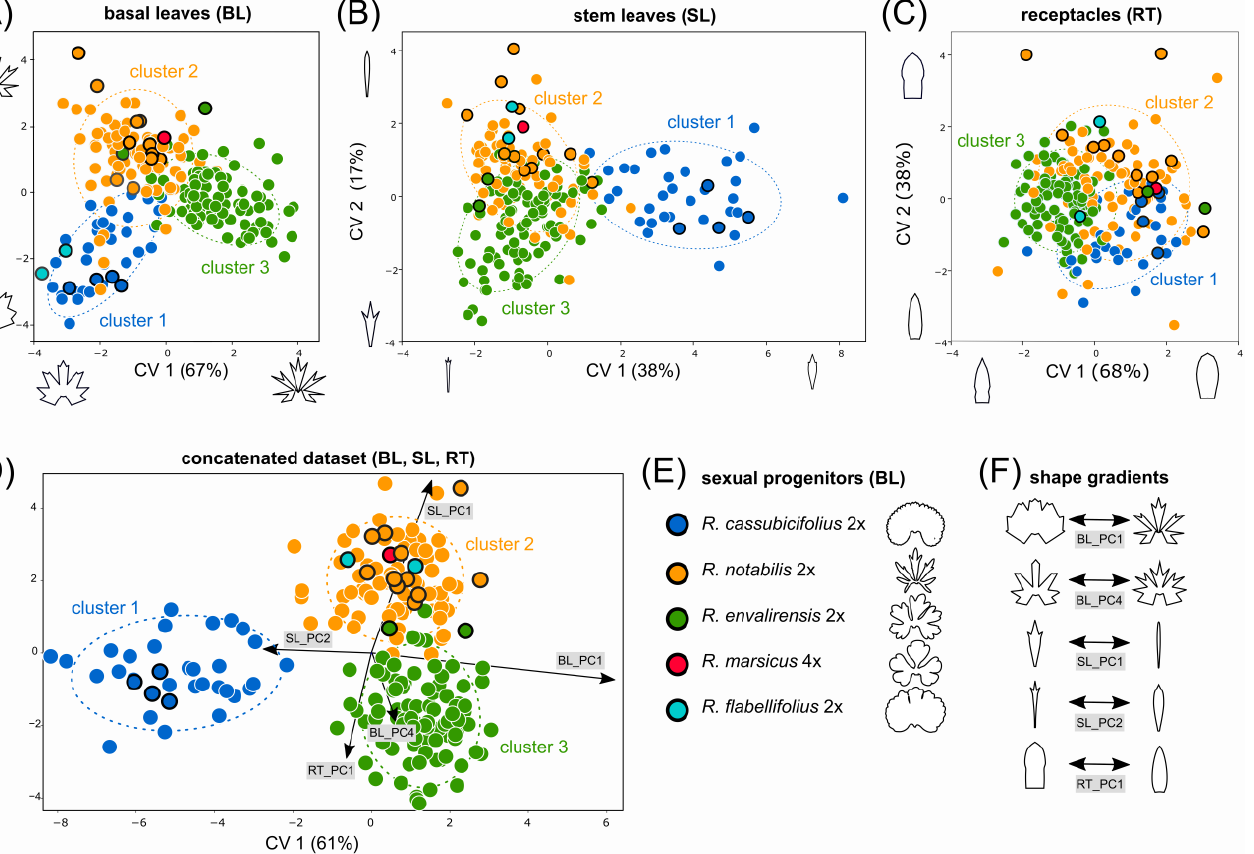
Figure 3. Morphological variation among sexual progenitors and polyploid apomictic derivative taxa with respect to genomic RAD-Seq (RADpainter) background. Canonical variate analyses (CVA) were applied for the clustering of 220 populations based on basal leaves ( A ), stem leaves ( B ), receptacles ( C ), and the concatenation of all traits ( D ). The concatenated analysis of all three traits (D) shows the five best separating morphometric trends illustrated in ( F ). Each dot in the CVA scatter plots ( A – D ) represents a single population, and the colors reflect assignments into the three RADpainter clusters (i.e., genomic clusters 1 – 3). An overview of the five sexual species in ( E ) shows their characteristic basal leaf morphotype, the most important taxonomic trait. The five best-separating shape trends (shape changes along the relative warps) are visualized in ( F ). The coloring of sexual progenitors and clusters follows Figure 2 and [51]. BL = basal leaves, Cluster 1 = RAD-Seq (RAD- painter) cluster 1 containing R. cassubicifolius and polyploid apomictic relatives, Cluster 2 = RAD- Seq (RADpainter) cluster 2 containing R. flabellifolius , R. marsicus , and R. notabilis and polyploid ap- omictic relatives, Cluster 3 = RAD-Seq (RADpainter) cluster 3 containing R. envalirensis and poly- ploid apomictic relatives, CV = canonical variate (explained percentages of shape variation), SL = stem leaves, RT = receptacles. A detailed look at the morphospace trait occupation of the sexual progenitors and polyploid apomictic derivatives indicates the presence of transgressive apomictic pheno- types (compare Figure 3 and Figure S7). We detected a set of apomictic populations that grouped outside the range of sexual progenitors for all three traits and in the concatenated data analysis. Transgressive phenotypes were established along all three morphological traits and all three clusters but were most abundant in cluster 3. 3.2. Comparison of Morphological Clustering Concerning Different Genomic Backgrounds We inferred significant morphological clustering according to genomic RAD-Seq (RADpainter, sNMF, NeighborNet clusters), nuclear gene TEG (Stacey clusters), and CP backgrounds (plastid clades) in CVA analyses (Table S2). Nevertheless, morphological clustering is best resolved by genomic RAD-Seq data showing the highest average differ- entiation value among clusters (F = 15.18 for RAD-Seq > F = 10.87 for CP > F = 8.29 for TEG; p values in Table S2; Figure 4A – E) inferred from the concatenated datasets. Though only